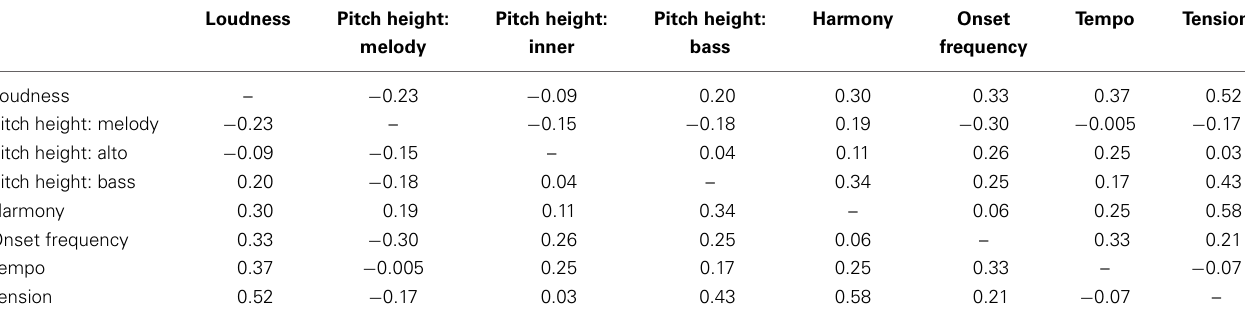
Table 2 | Spearman ρ values for correlations between features and mean tension (second rating only). Loudness Pitch height: Pitch height: Pitch height: